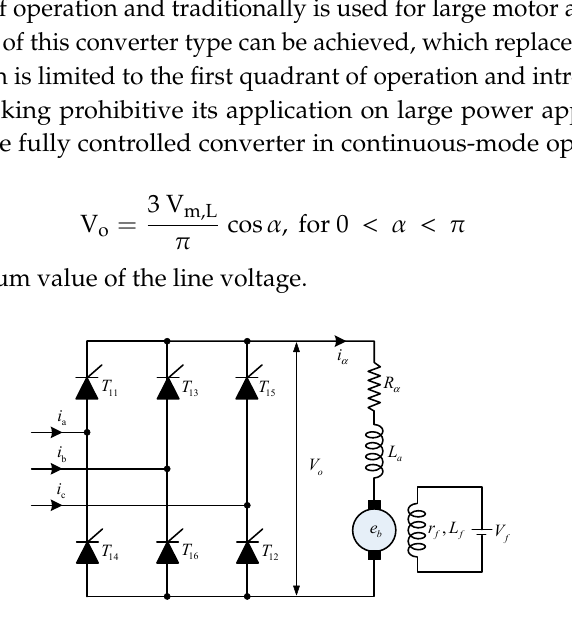
Figure 8. Three-phase fully-controlled converter.